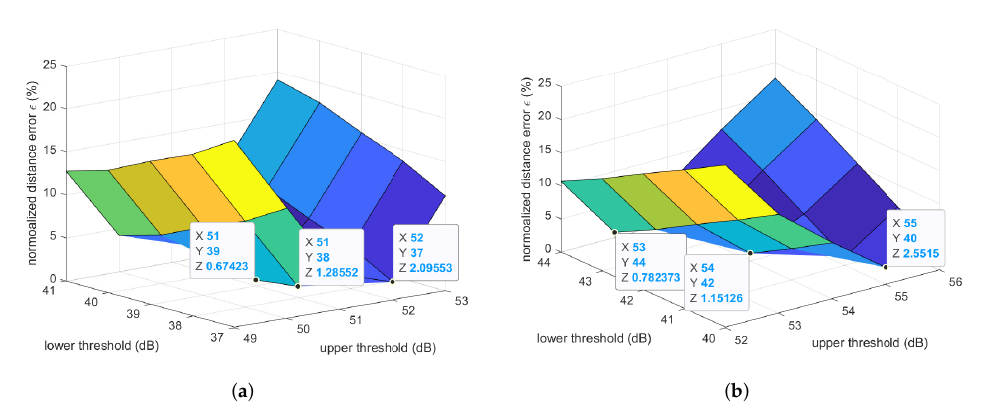
Figure 8. Normalized step length estimation errors of the outdoor experiments. ( a ) Outdoor walking; ( b ) Outdoor